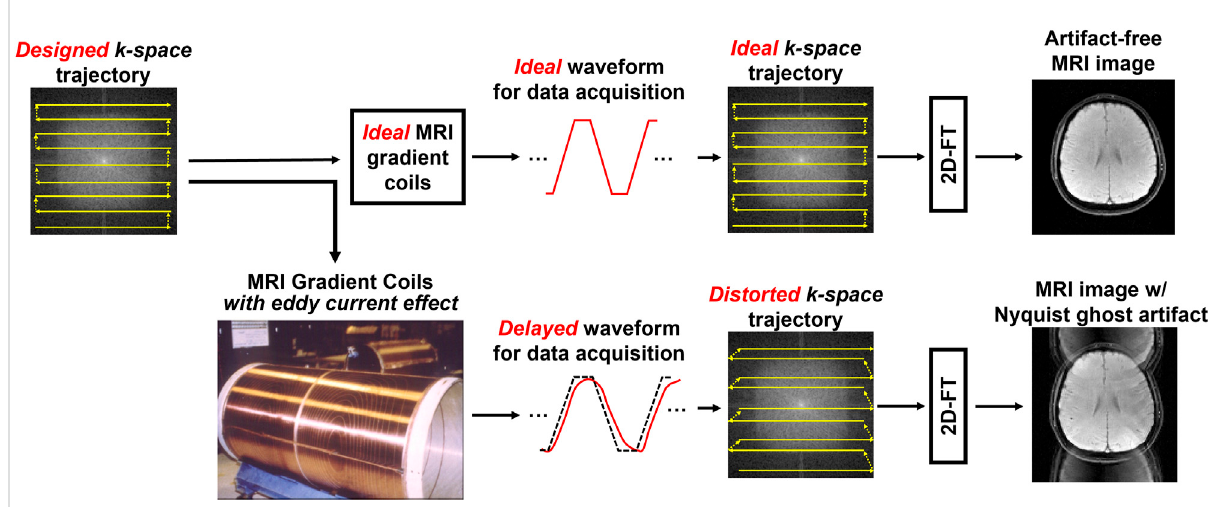
FIGURE 1 The demonstration of the cause of Nyquist ghost artifact in two-dimensional single-shot echo planar imaging (2D-ssEPI). The ideal gradient waveform for data sampling can produce an artifact-free MRI image with rapid back and forth traversal trajectory in k-space (upper). However, the hardware imperfection, such as eddy current effect of gradient coil, can lead to delayed gradient waveform, resulting in distorted k-space trajectory (lower). The misalignments of k-space lines cause the Nyquist ghosting